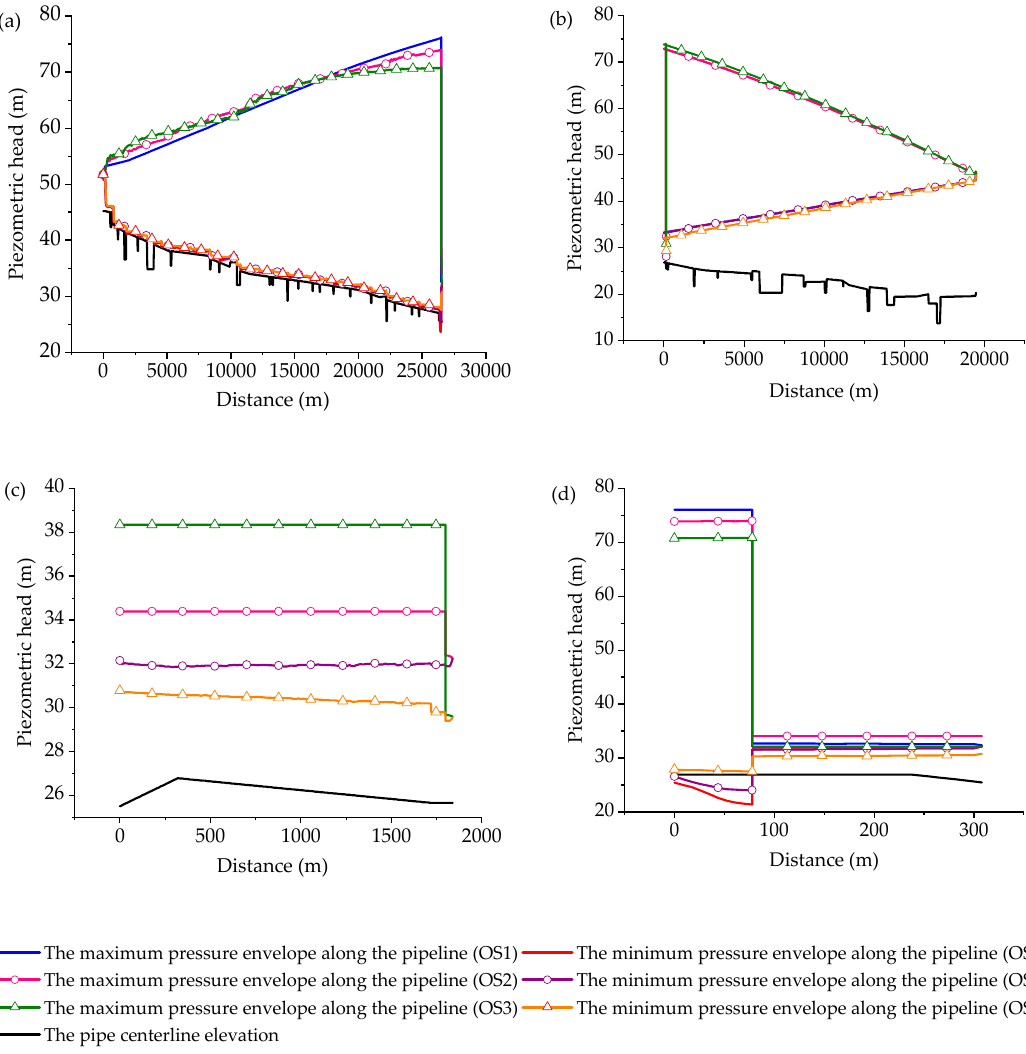
Figure 8. ( a – d ) The pressure envelopes along pipe ① , ② , ③ , and ④ .